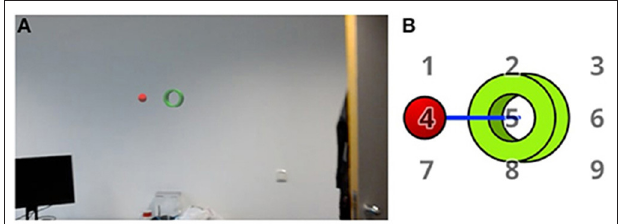
FIGURE 2 | The alignment-task: (A) Example scene from the HoloLens, showing green tube and unaligned red ball in front of a white wall. (B) Schematic display of the tube and the ball together with the imagined number pad for internal trials. The blue line indicates a ball movement from 4 to 5. Taken from Vortmann et al.